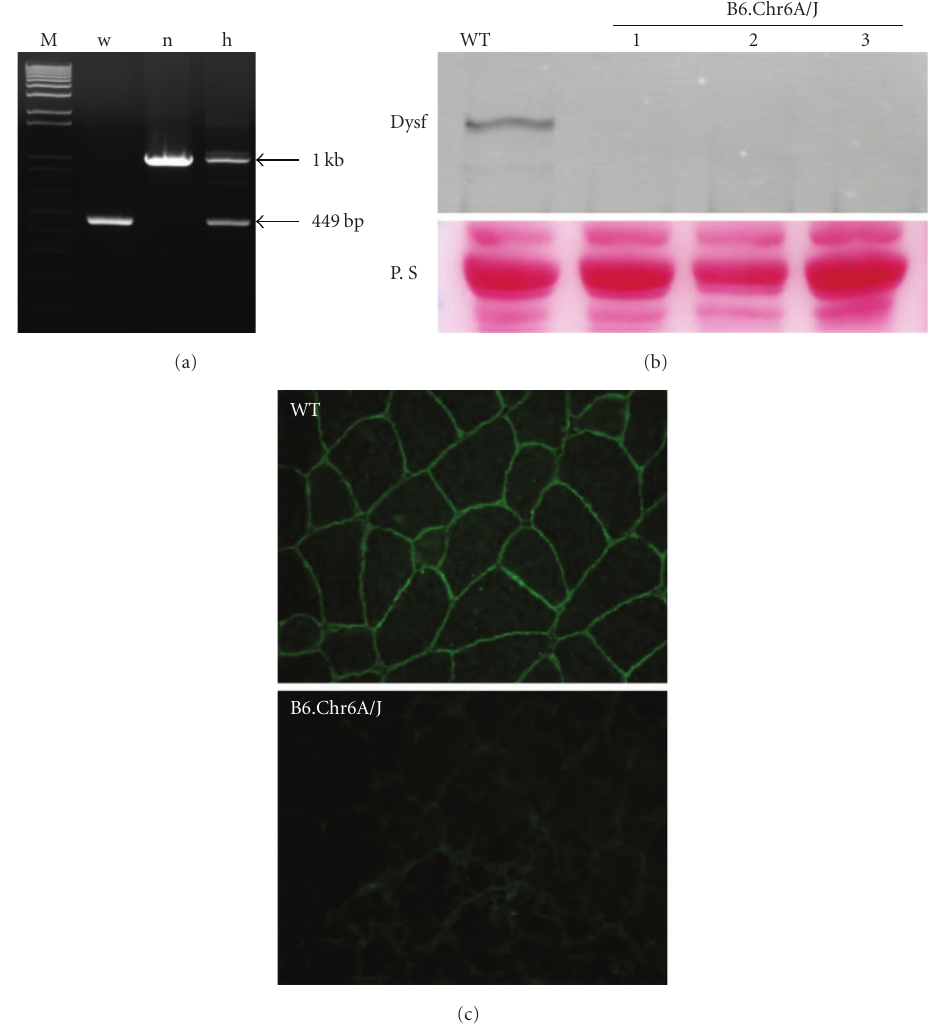
tension indicates Ca 2+ /Na + entry through saponin-induced membrane pores, while the subsequent decrease in